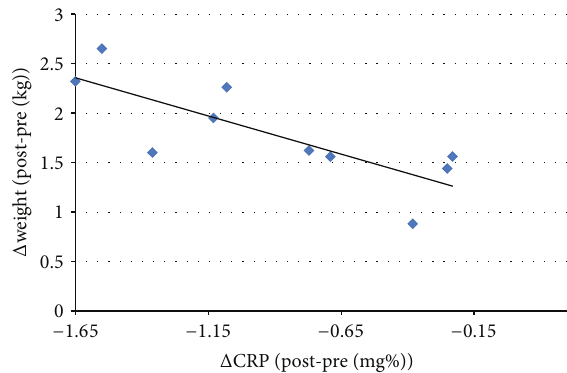
Figure 3: A correlation between the decrease in circulating CRP levels after surgery and the weight the child gained after surgery. The greater the fall in CRP levels the more the weight the boys gained after surgical intervention ( 𝑟 = −0.775 , 𝑃 = 0.041